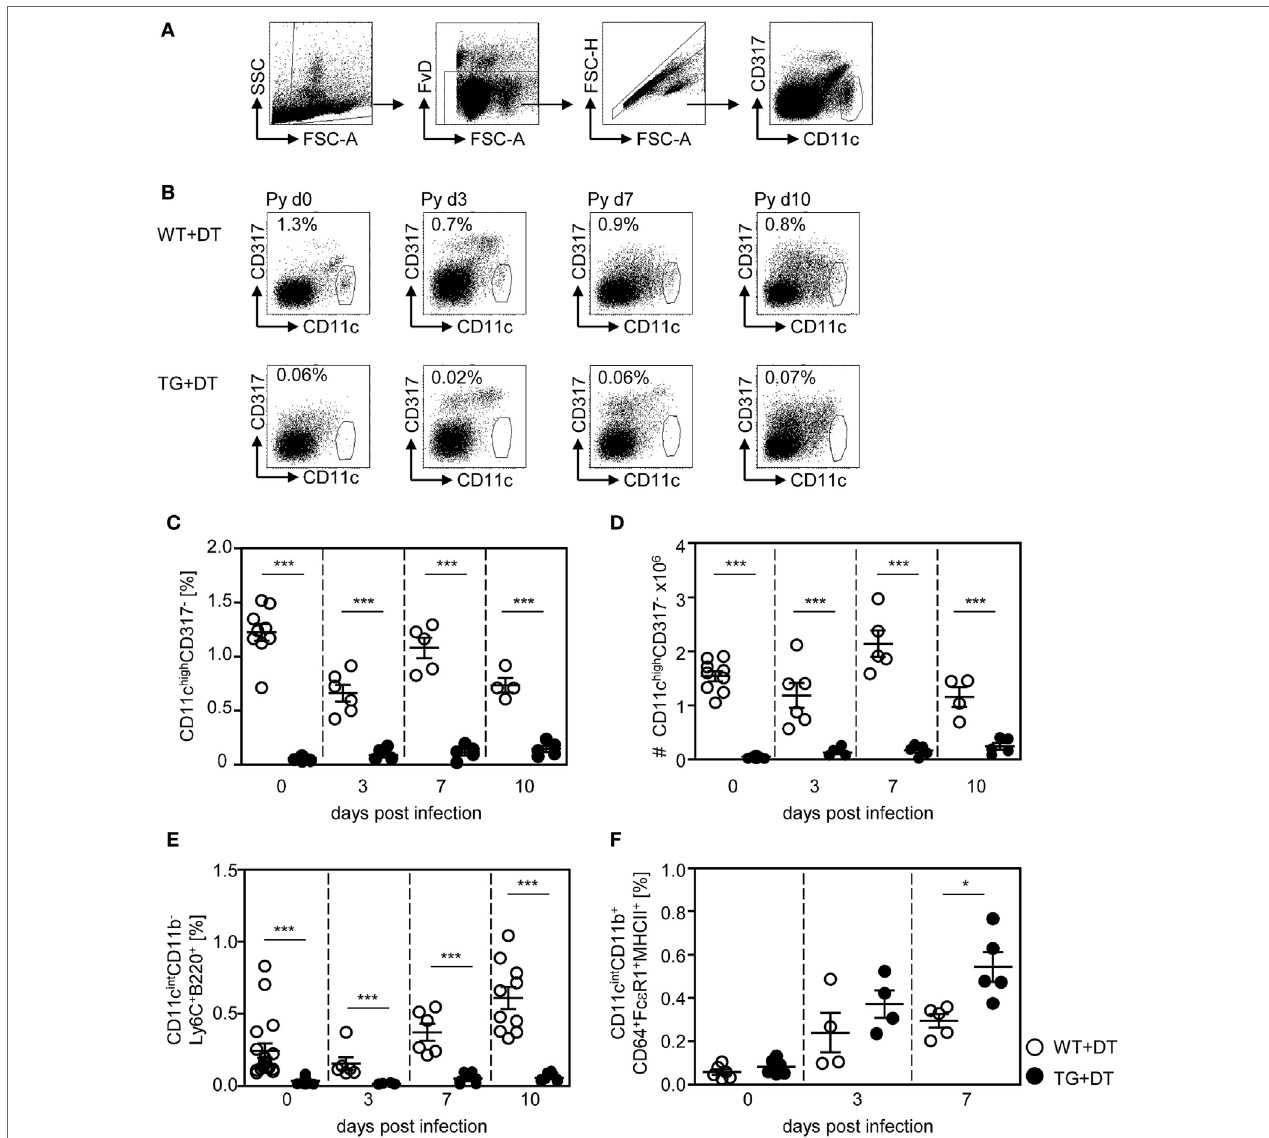
FigUre 1 | Efficient long-term depletion of CD11c high dendritic cells (DCs) in diphtheria toxin (DT)-treated RosaiDTR/CD11c-cre mice. Transgenic RosaiDTR/ CD11c-cre (TG) and control RosaiDTR wild-type (WT) mice were treated every day with DT ( + DT) starting 1 day before infection with Plasmodium yoelii . At indicated time points, the percentage of splenic (c) CD11 high CD137 low DCs was determined by flow cytometry. The gating strategy is illustrated in (a) , representative dot plots are shown in (B) . (D) Absolute cell numbers of CD11 high CD137 low DCs were calculated and (e) the frequencies of CD11 int CD11b − Ly6C + B220 + plasmacytoid DCs (pDCs) and (F) CD11c int CD11b + CD64 + Fc ε RI + MHCII + cells were measured by flow cytometry. Data from two independent experiments with n = 4–9 mice per time point were summarized as mean ± SEM. Each data point represents one animal. Student’s t -test was used for statistical analysis with * p < 0.05 and *** p <